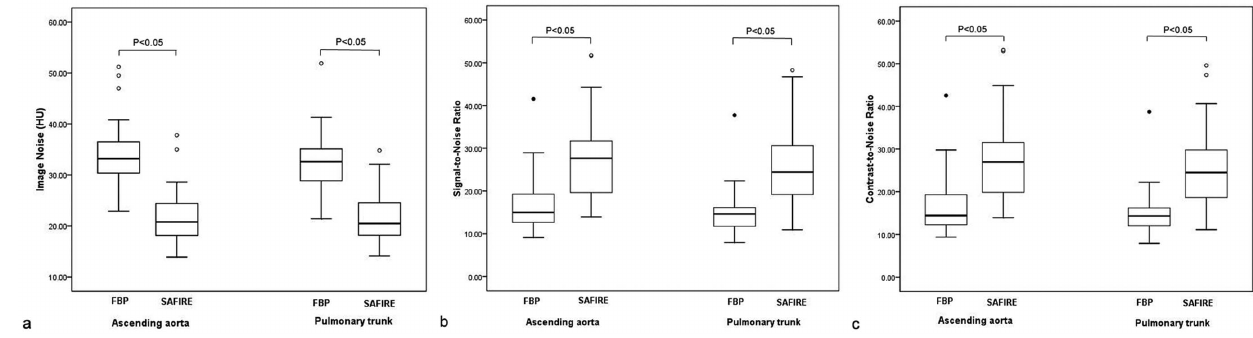
Figure 3. Box-and-whisker plots of objective analysis of image quality acquired with FBP and SAFIRE algorithms. Image noises of ascending aorta and pulmonary trunk were significantly lower with SAFIRE algorithm than with FBP algorithm (a). Signal-to-noise ratios and contrast- to-noise ratios of ascending aorta and pulmonary trunk were significantly higher with SAFIRE algorithm than with FBP algorithm (b,c). Center horizontal lines show median values and whiskers represent upper and lower quartiles. # /